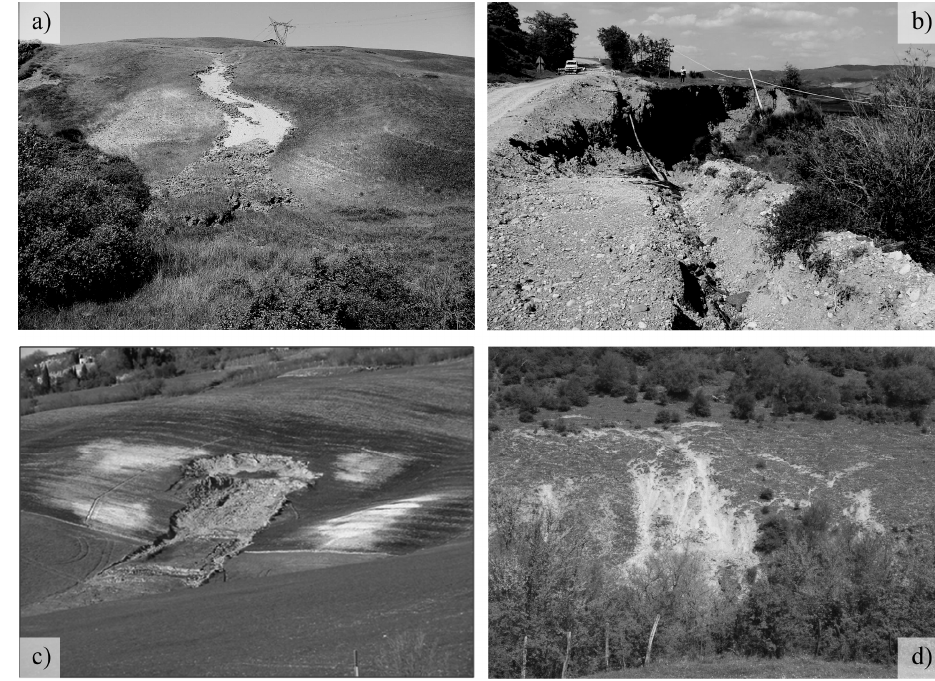
Figure 5: Examples of the mass movements widespread in the study area: a) mud flow; b) earth 2 Fig. 5. Examples of the landslide types widespread in the study area: (a) mud flow; (b) earth slump; (c) complex landslide (earth slump evolving into a mud flow); (d) shallow mass slump; c) complex landslide (earth slump evolving into a mud flow); d) shallow mass movements. 3